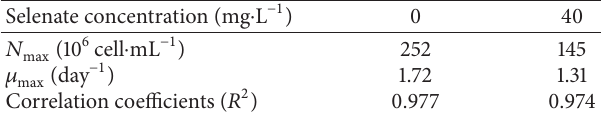
Table 1: Values of growth parameters 𝑁 max (10 6 cell ⋅ mL − 1 ) and 𝜇 max (day − 1 ) obtained by fitting logistic model equation to experimental data of population density in function of time from selenium exposed culture and control. Model curve was fitted to mean values of population density data (see Figure 1); hence, fitted models give single parameters values, instead of 𝑁 max and 𝜇 𝑚 mean values ±